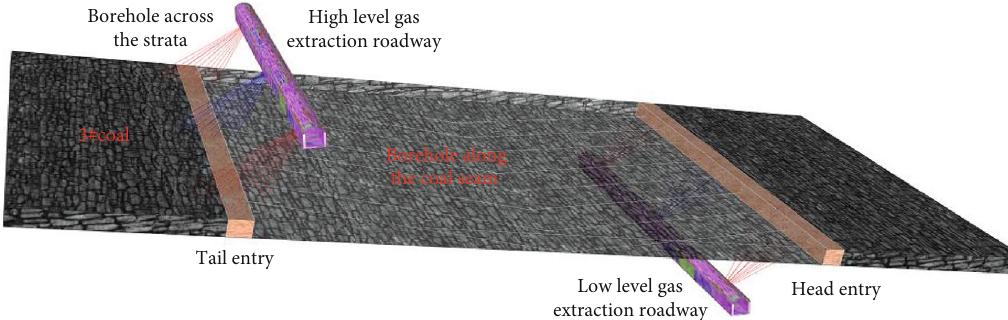
Figure 11: Schematic of stereoextraction of gas.